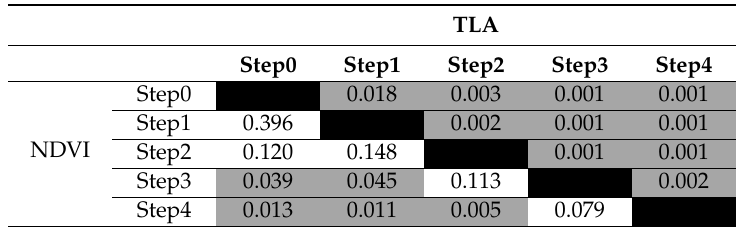
Grey colour denotes p -values < 0.05. Diagonal values were excluded and marked in black.